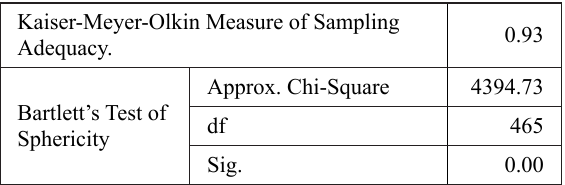
Table 2. KMO and Bartlett’s Test Kaiser-Meyer-Olkin Measure of Sampling Adequacy. Bartlett’s Test of